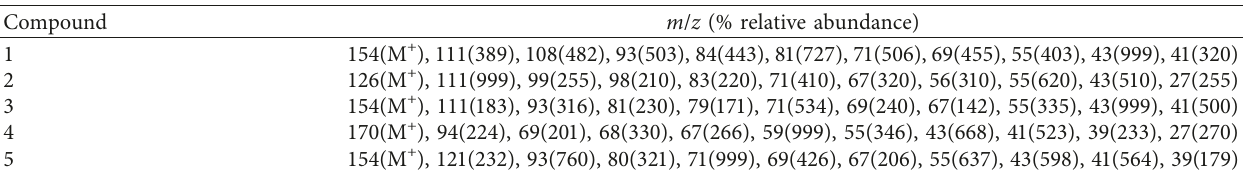
Table 15: Mass spectra of compounds 1–5 of whole plant n -hexane fraction of Achillea wilhelmsii (WHFAW).